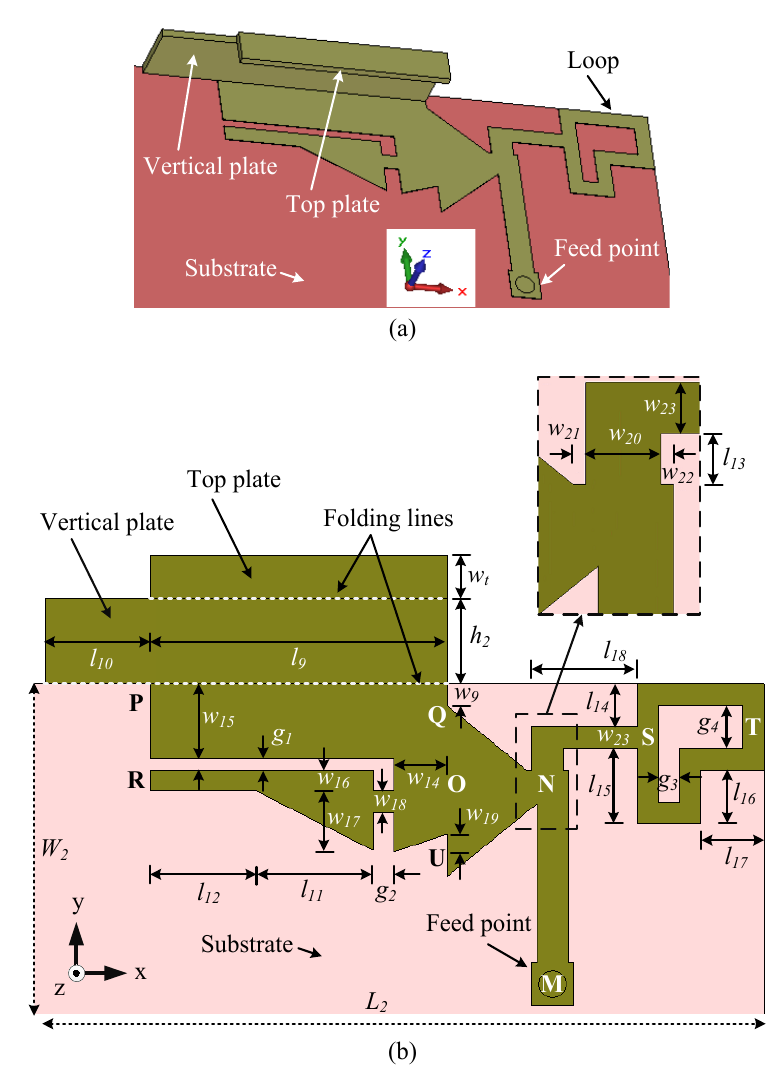
Figure 12. Configuration of the wideband antenna (Ant#3) for the LSA bands, as well as the LTE/WWAN mid and high bands: ( a ) perspective view, and ( b ) top view (vertical plate is unfolded along the +y axis).